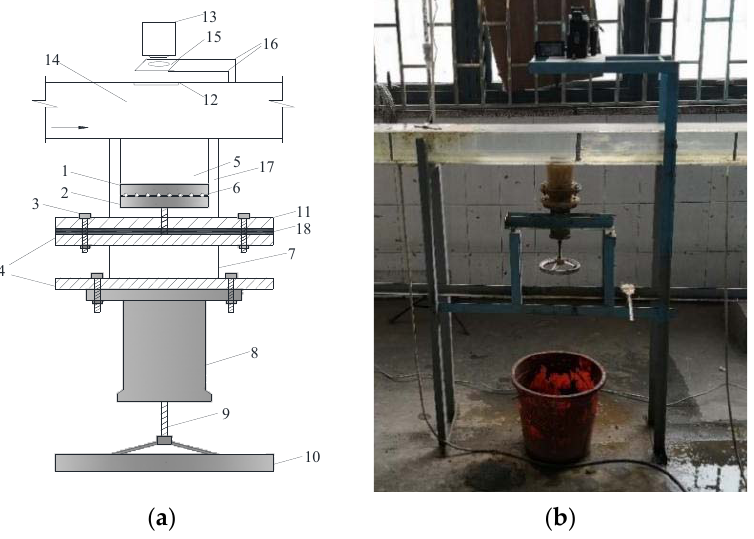
Figure 5. Topsoil device and shooting device of cohesive soil samples: 1—stainless steel upper tray; 2—stainless steel lower tray; 3—screw; 4—flange; 5—cohesive soil sample; 6—steel ball; 7—transparent organic glass flume; 8—stainless steel sealed steel pipe; 9—bolt; 10—stainless steel handle; 11—flange connecting cohesive soil sample device and the flume; 12—lighting source; 13—video camera; 14—flume; 15—organic transparent glass plate for placing camera lens; 16—parallel angle steel; 17—organic transparent glass pipe fixed at the bottom of the flume and connected with a flange; 18—rubber blanket. ( a ) Schematic diagram of topsoil device and shooting device ( b ) Physical pictures of topsoil device and shooting device.